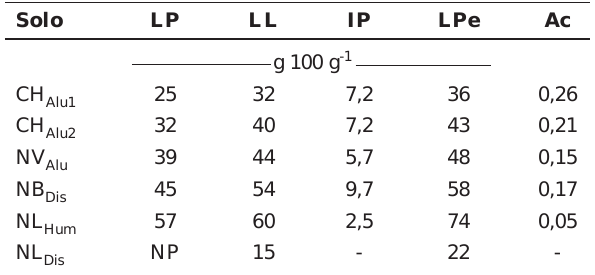
CH = Cambissolo Húmico alumínico típico 1; CH Alu1 alumínico húmico; NB = Nitossolo Bruno distrófico típico ; NL Dis distrófico